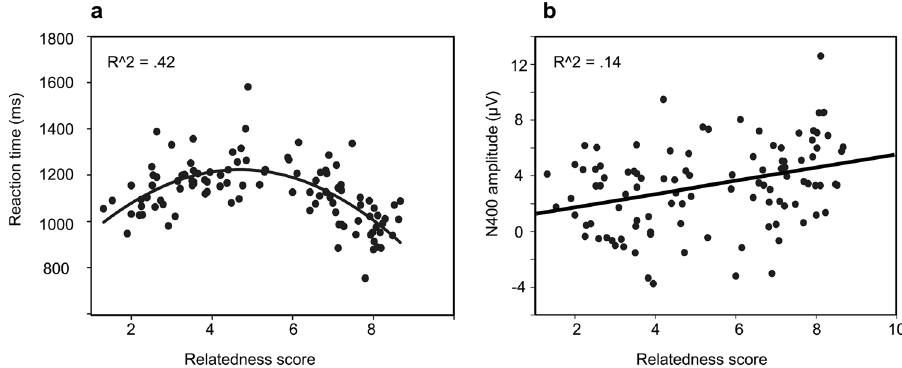
Figure 4. Scatter plots with best-fitting fitted regressions. ( a ) Fitted quadratic regression line for RTs of Exp 2. against the relatedness rating scores of Exp 1. ( b ) Scatter plot and fitted linear regression line for N400 amplitude of Exp 2. against relatedness rating scores of Exp